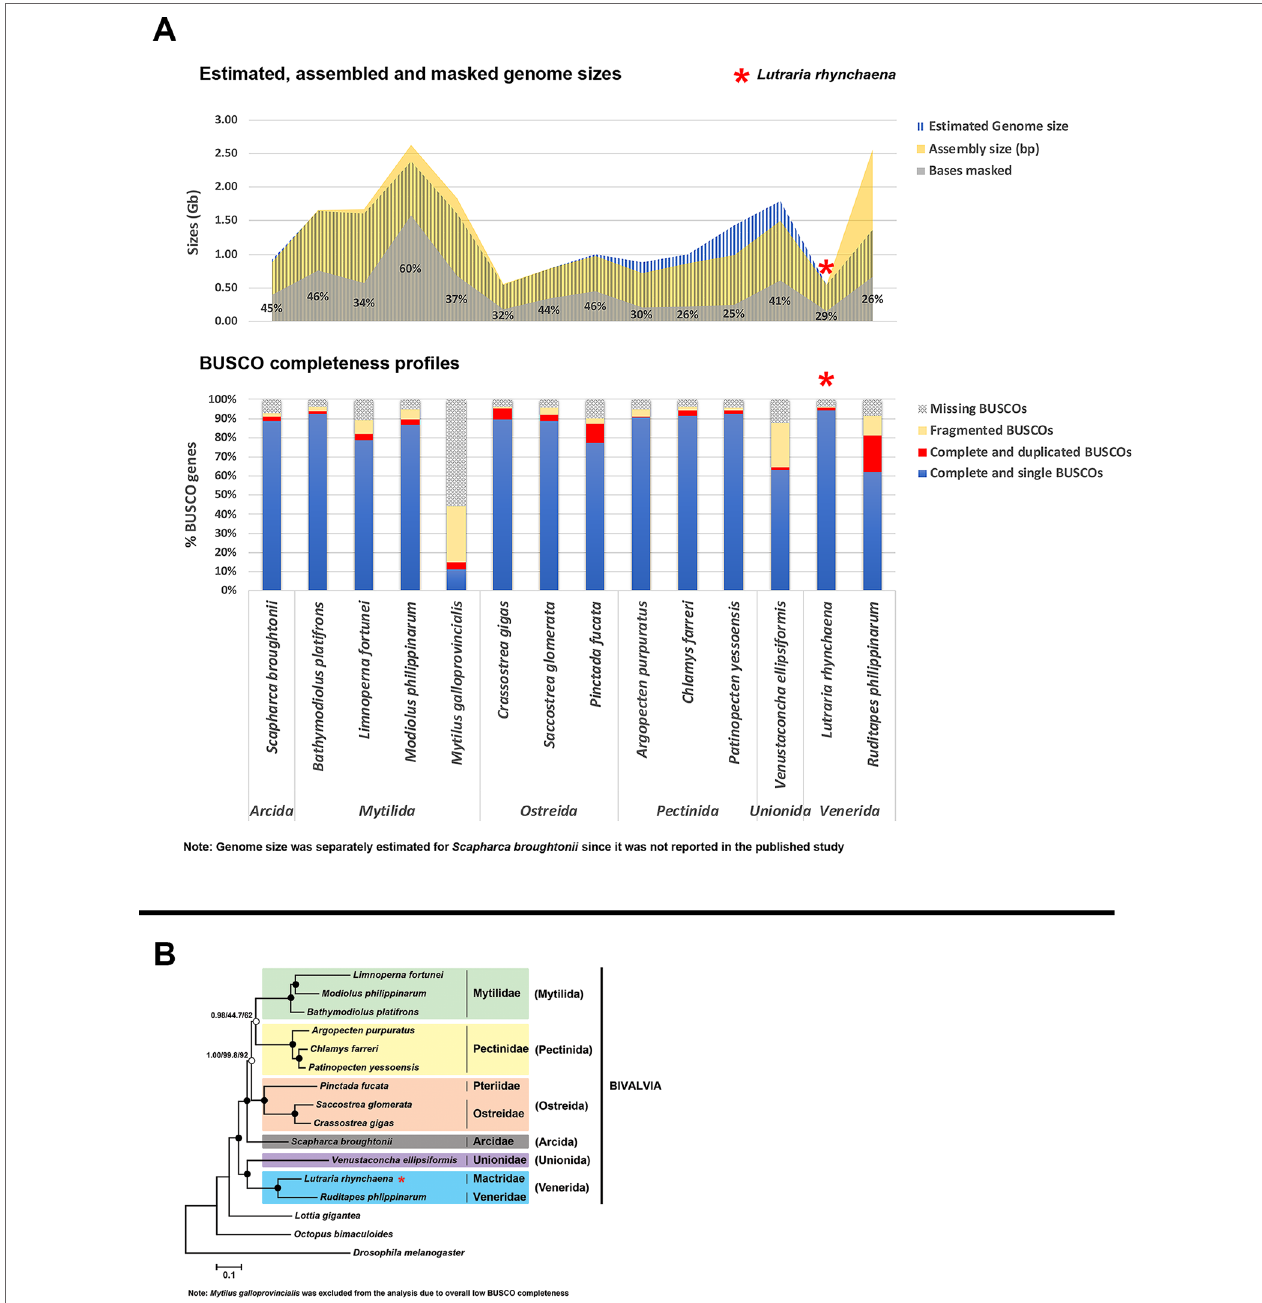
FIGURe 1 | Comparison of Lutraria rhynchaena against other published bivalve assemblies. (A) Comparison of BUSCO completeness, estimated vs assembled genome sizes and repeat content. (B) Evolutionary relationships among bivalve species inferred from maximum likelihood (ML) and Bayesian (BI) methods. Rooted with Drosophila melanogaster , the shown BI topology was inferred from a supermatrix of 22,668 amino acid characters was constructed from the alignments of 129 orthologous protein groups. Closed circles indicate maximum nodal support values (BPP/SH-aLRT/UFBoot).